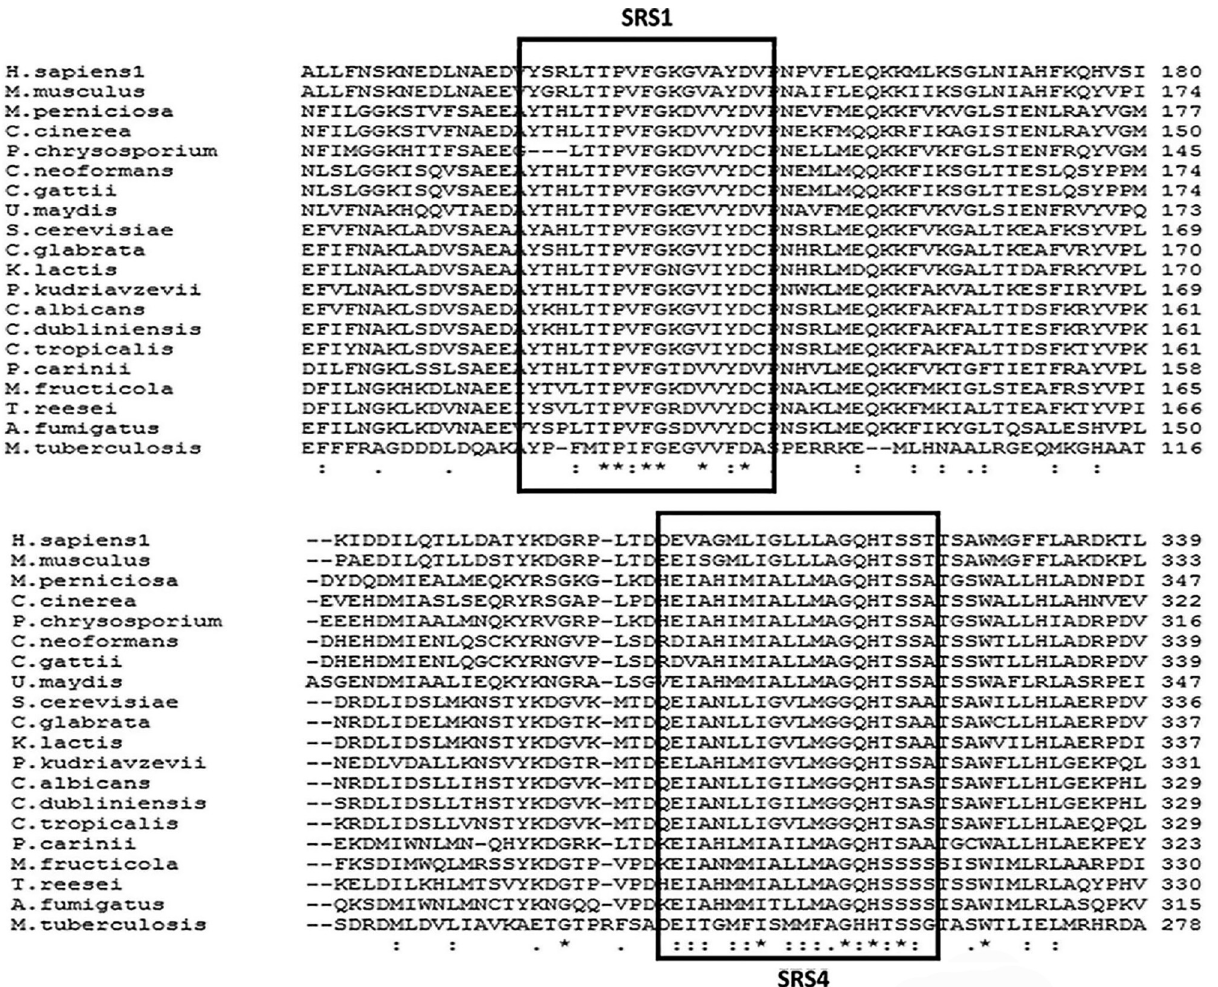
Figure3 - Moniliophthoraperniciosa CYP51alignmentwithotherhomologousCYP51sequences.Conservedaminoacidresiduesthatcorrespondtothe heme-bindingsite(HBR),substraterecognitionsites(SRS1andSRS4)andEXXRmotifsareshowninboxes.Thearrowindicatestheconservedcysteine residue. Homo sapiens 1 - H. sapiens isoform 1 (NP_0000777.1), Mus musculus - Mus musculus (NP_064394.2), Moniliophthora perniciosa - Moniliophthora perniciosa (JX915631), Coprinopsis cinerea - Coprinopsis cinerea (AAU01159.1), Phanerochaete chrysosporium -